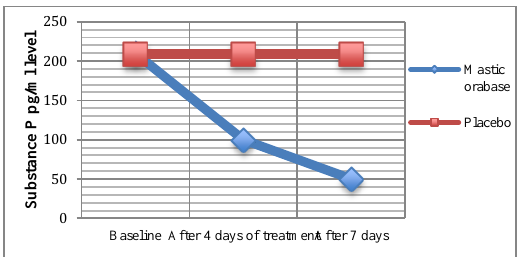
Fig. 5: Saliva substance P values at baseline, 4 days after treatment, and after 7 days for mastic orabase and placebo treated groups. Saliva TGF_beta level of RAU subjects Table 3: Effectiveness index in ulcer size Saliva TGF-beta level was low at baseline in reduction mastic orabase, and placebo groups; 139.9±20.8 and 139.8±23.4Pg/ml, respectively. After 4 days of treatment, the level increased significantly in mastic orabase treated group (168.9±22.3Pg/ml) compared to baseline (P=0.01), then the TGF-β level increased significantly to 180±40.7Pg/ml (P=0.02) after 7 days, but placebo group showed no statistical differences after 4 days of treatment, and after 7 days (P=0.8), as showed in figure (6).